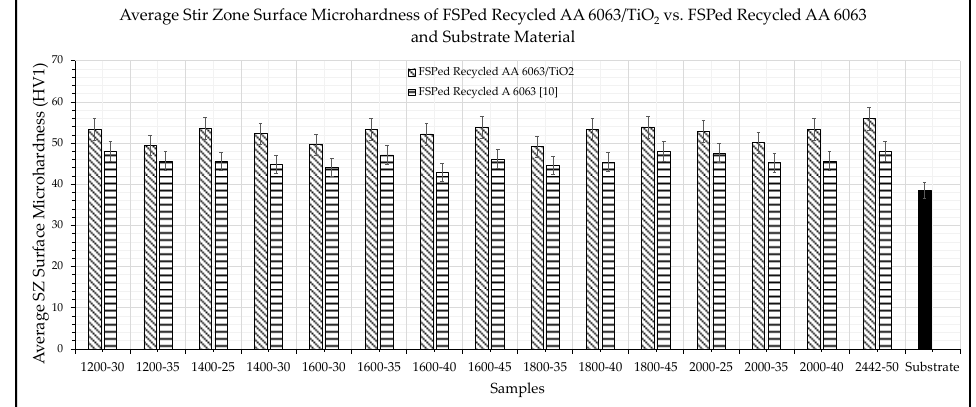
Figure 13. Average surface microhardness of substrate material and FSPed recycled AA 6063/TiO 2 produced by different processing parameters.